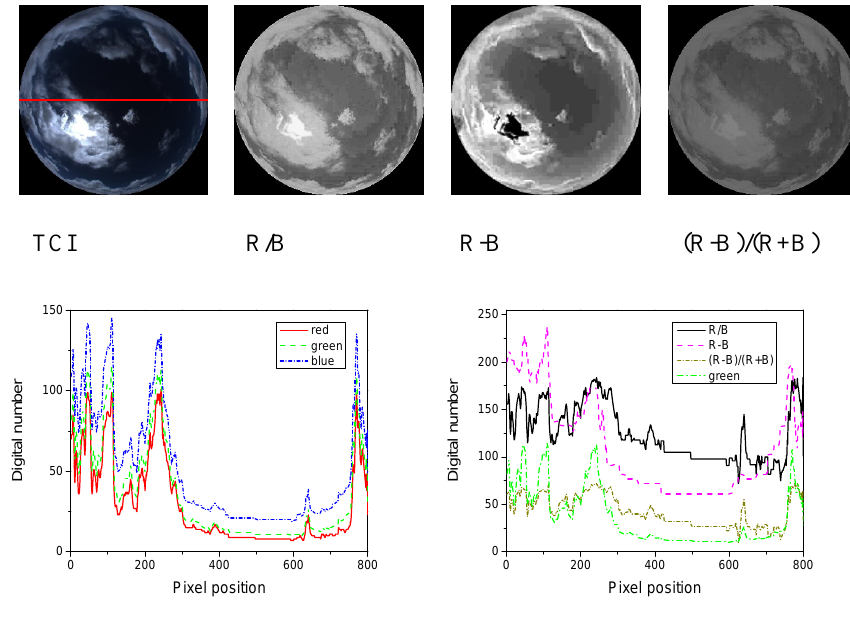
Figure 2. Brightness distribution for different channels.